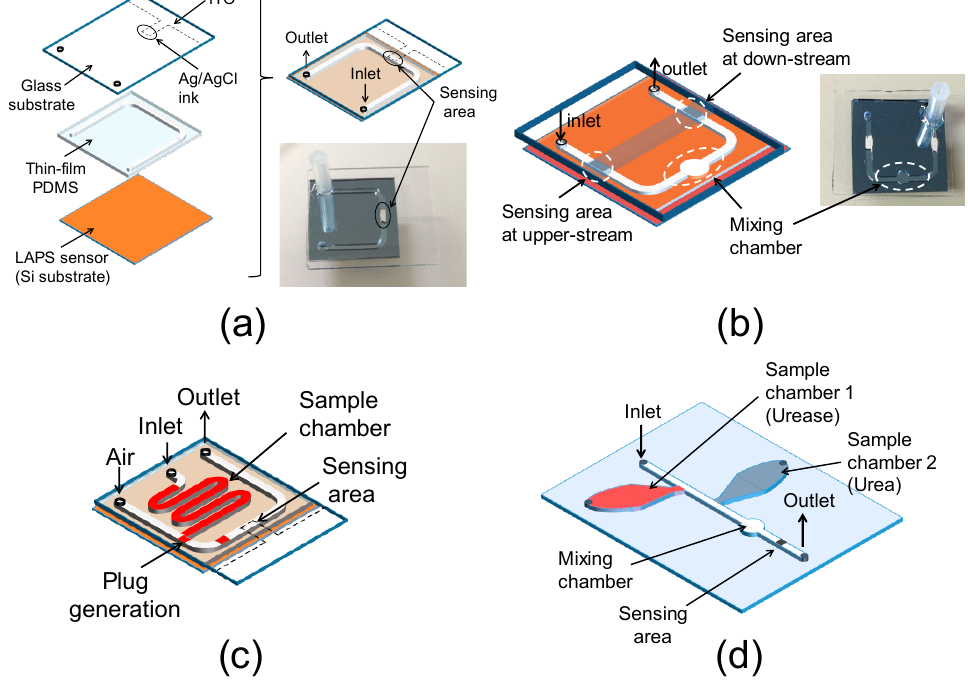
Figure 1. ( a ) Test structure of the microfluidic device combined with LAPS; ( b ) Channel design with a chamber for merging and differential measurement; ( c ) Channel design to generate plugs on chip; ( d ) Test structure with two sample chambers, one merging chamber, and one sensing area.